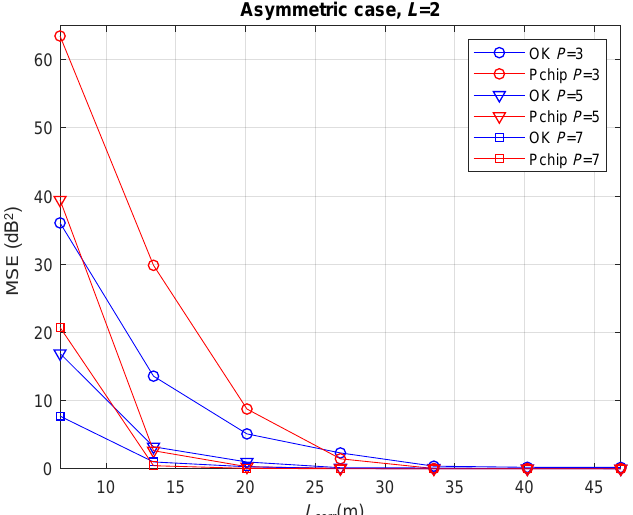
Figure 7. Minimum MSE of path-loss and shadowing estimation versus shadowing correlation distance in the asymmetric case with L = 2